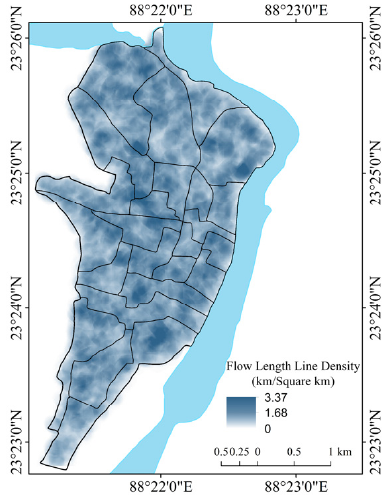
Figure 20. NDVI (2000). Figure 21. NDWI (2000).